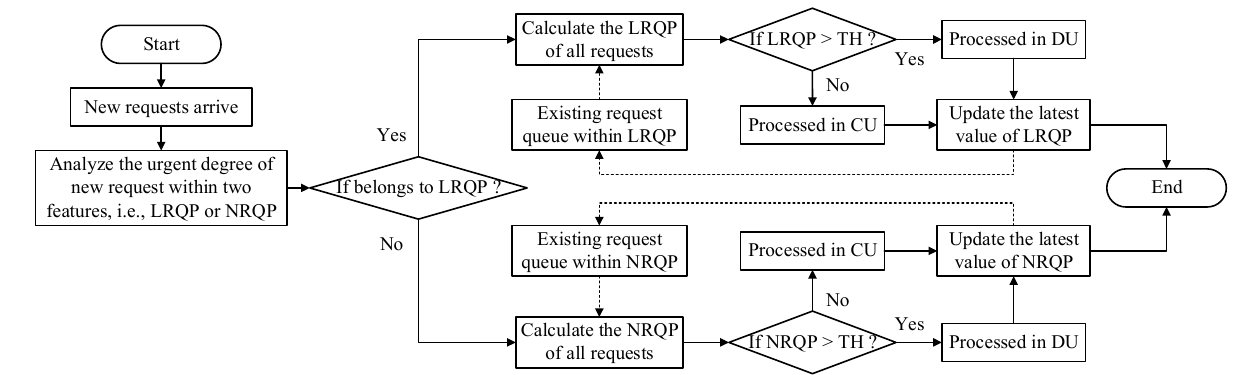
Figure 5. The procedure of the priority model for traffic requests.